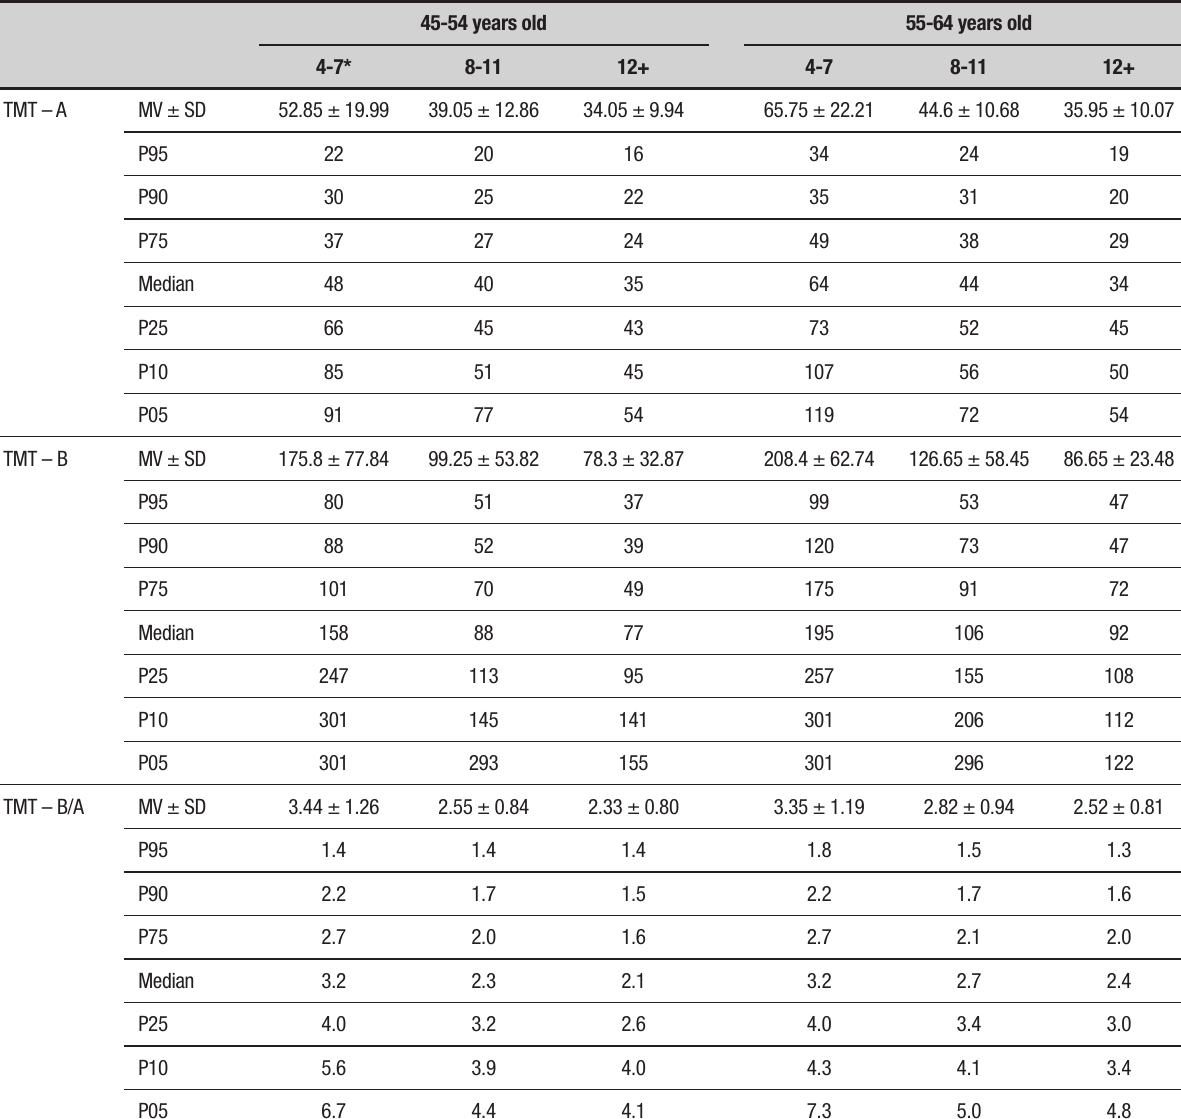
Table 2. Normative data for Trail Making